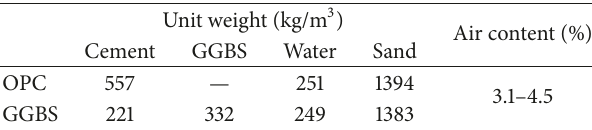
Table 2: Mortar mix proportion for the experimental